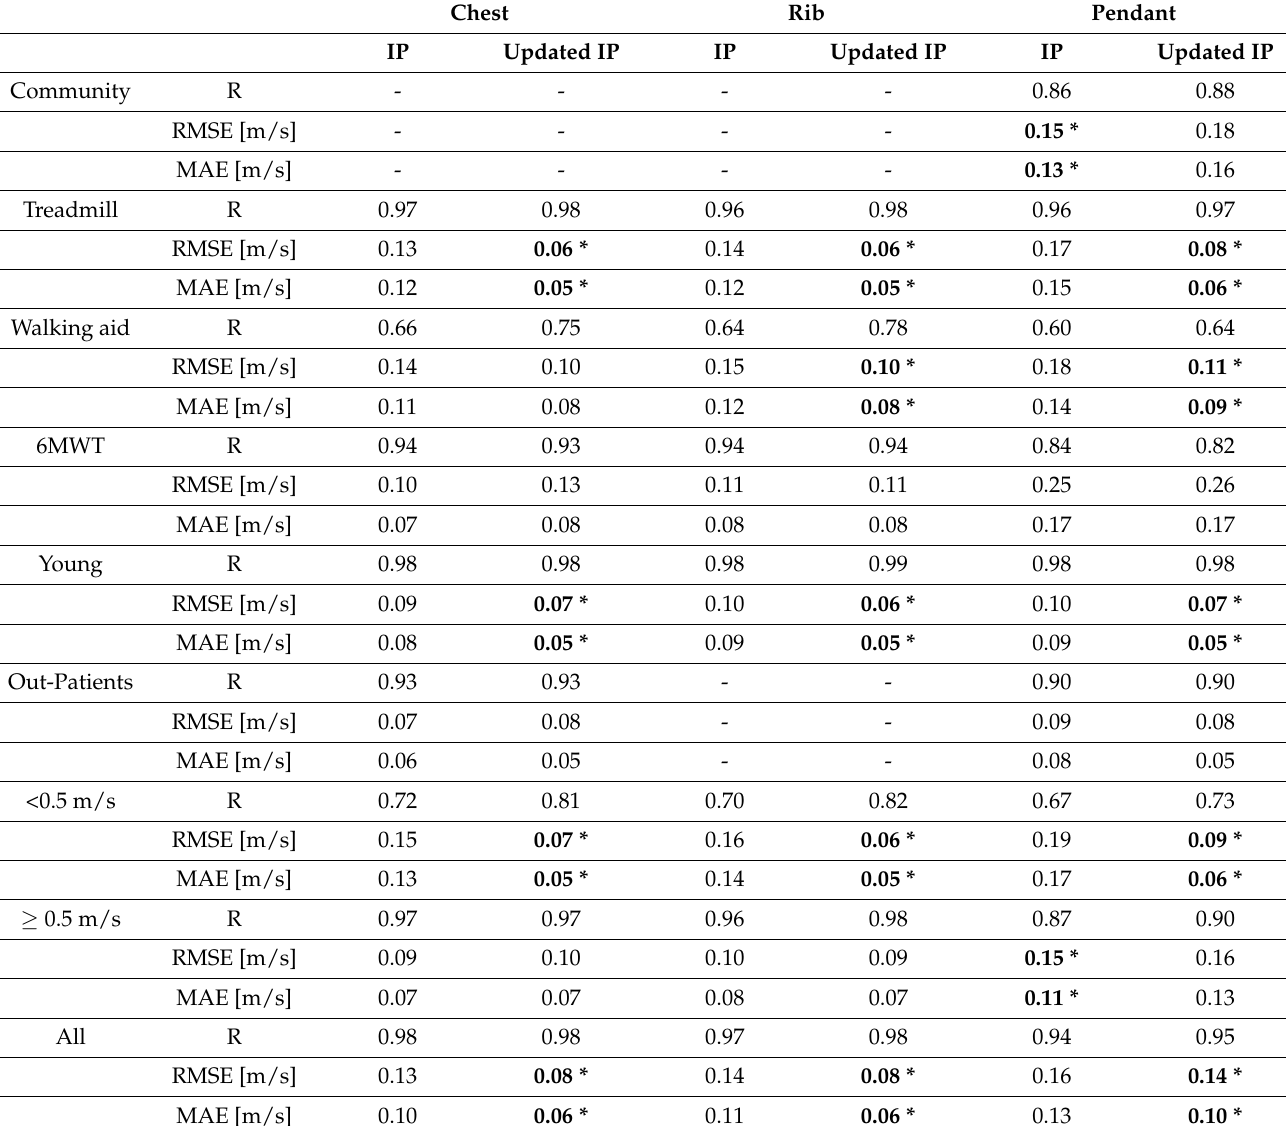
Table 2. Pearson correlation Pearson correlation (R), root mean square error (RMSE), and mean absolute error (MAE) for the three locations and two methods. The lower nine rows show the results for the combined data for speeds below 0.5 m/s, for speeds ≥ 0.5 m/s and for all data combined. * Indicates that the Wilcoxon signed-rank test showed that the underlying absolute errors were statistically significantly lower for this algorithm compared to those for the other one, with p <